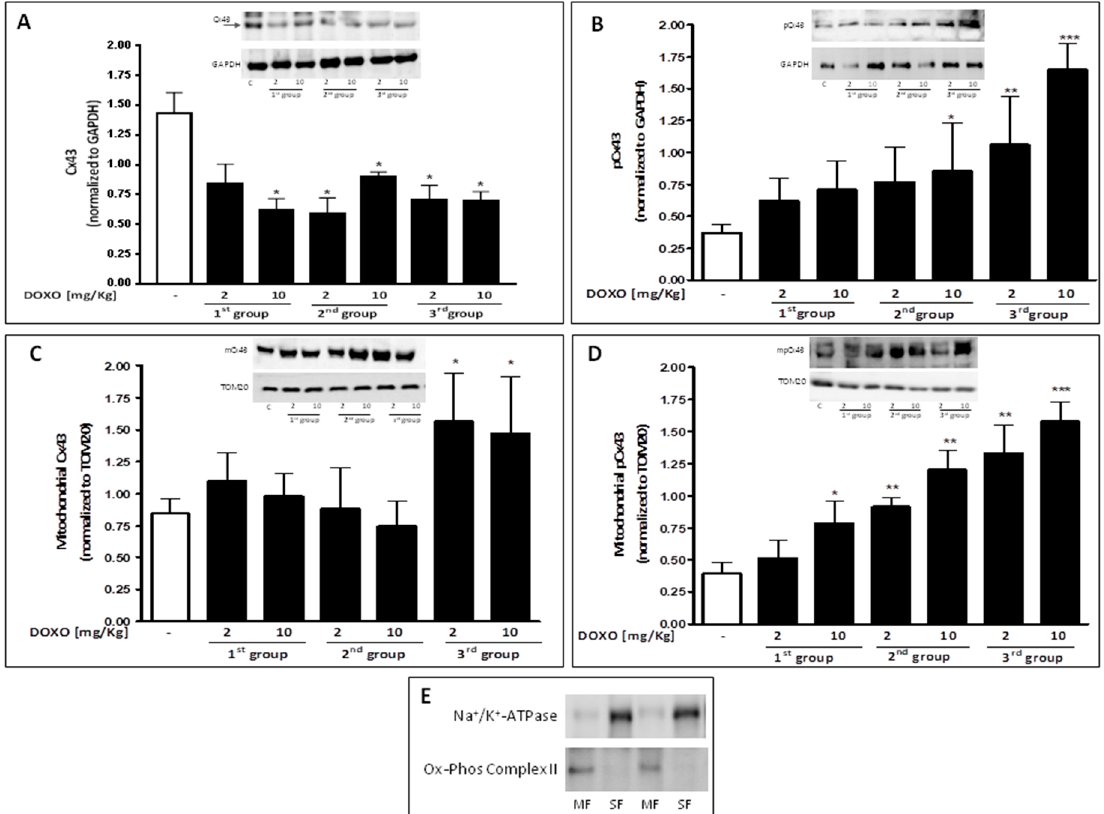
Figure 2. Mice received a single administration (first group), two administrations (second group), or three administrations (third group) of DOXO (2 mg/kg and 10 mg/kg; i.p.) and Cx43 and pCx43 expressions were detected by Western blot analysis into tissue homogenates from mice; GAPDH protein expression was used as loading control ( A , B ); Effects of DOXO on mCx43 ( C ) and mpCx43 ( D ) expression were detected by Western blot analysis on mitochondrial protein lysate from mice; TOM20 protein expression was used as loading control. Values were expressed as mean ± S.E.M. from at least three independent experiments each performed in duplicate. Values are expressed as mean ± S.E.M. from at least three independent experiments each performed in duplicate. Data were analyzed by Student’s t -test. * p < 0.05, ** p < 0.005 and *** p < 0.001 versus control. Representative Western blots of Na + /K + ATPase and Ox-Phos Complex II were used as markers of sarcolemma (SF) and mitochondria (MF), respectively, to demonstrate the purity of the mitochondrial extracts ( E ). Western blot analysis performed on heart lysates of treated-mice confirmed that, compared to control mice, DOXO-treated mice had a significant ( p < 0.05) reduction of Cx43 expression, that could